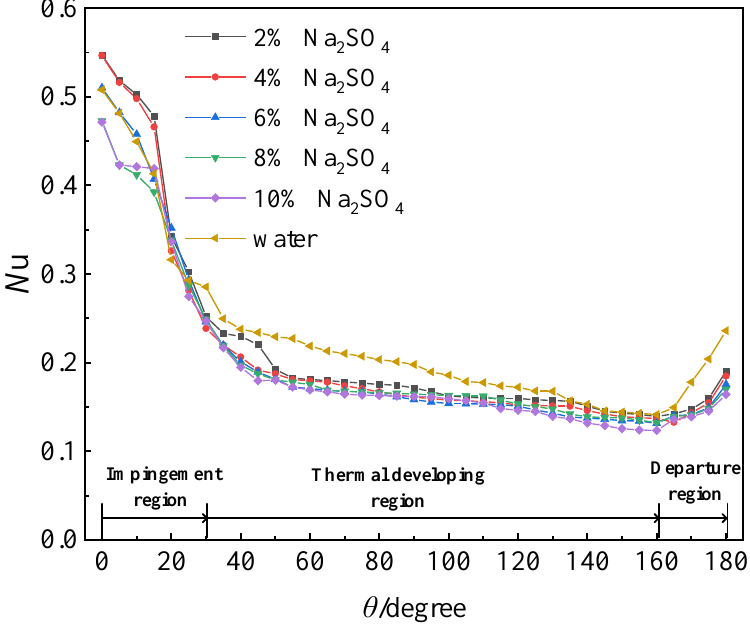
Figure 4. Local Nusselt number around the tube under various Na 2 SO 4 content.